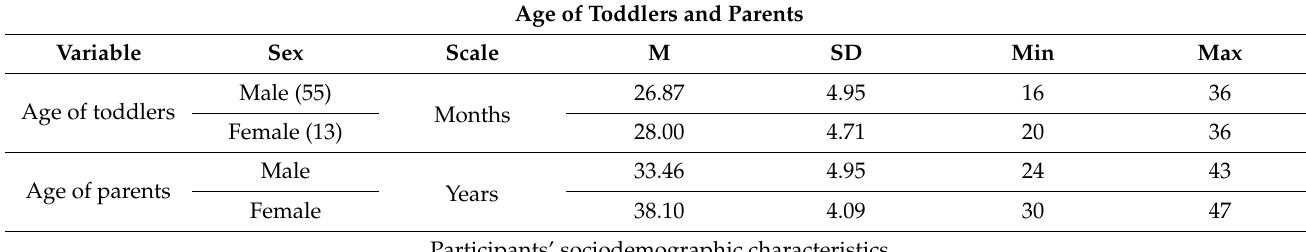
Table 1. Participants’ sociodemographic characteristics. The children did not attend daycare. Age of Toddlers and